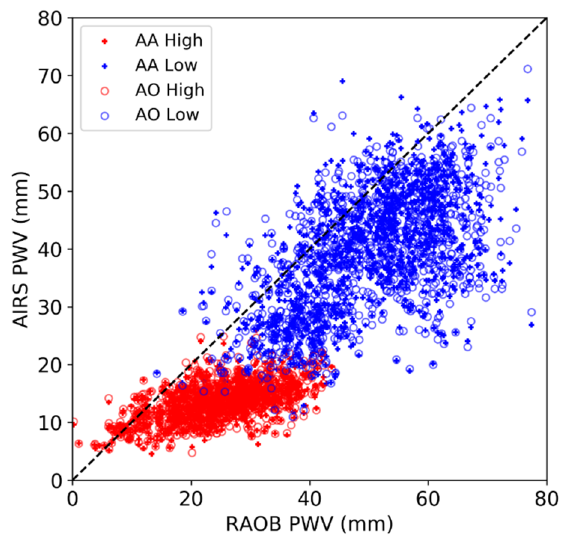
Figure 6. Scatterplots of AIRS / AMSU (AA) precipitable water vapor (PWV), AIRS-only (AO) PWV, and radiosonde PWV over different terrain heights, from 20 June to 31 July in the years 2011 to 2016. Table 2. Linear regression of AIRS / AMSU (AA) and AIRS-only (AO) against RAOB for PWV, from 20 June to 31 July in the years 2011 to 2016 Data Groups